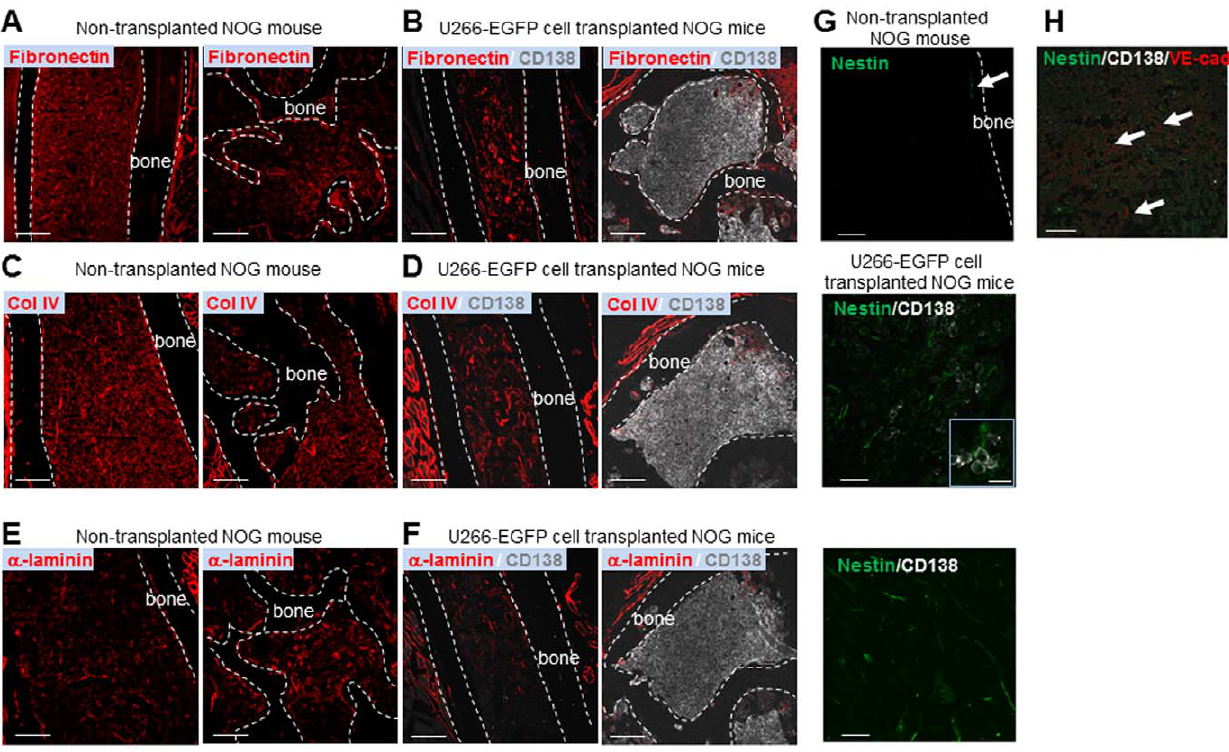
Figure 5. Disorganized ECM components and increased mesenchymal cells in the MM niche. A, B. IHC of fibronectin (red; A ), or fibronectin (red) and human CD138 (gray; B ), at the diaphyseal region (left) or metaphyseal region (right) of long bones of a non-transplanted NOG mouse ( A ) or U266-EGFP cell-transplanted NOG mice ( B ). Representative data from five fields from the BM of one non-transplanted NOG mouse and five U266-EGFP cell-transplanted mice in two independent experiments are shown. Bars=200 m m. C, D. IHC of type IV collagen (red; C ), or type IV collagen (red) plus human CD138 (gray; D ), at the diaphyseal region (left) or metaphyseal region (right) of the long bones of a non-transplanted NOG mouse ( C ) or U266-EGFP cell-transplanted NOG mice ( D ). Representative data from five fields from the BM of one non-transplanted NOG mouse and five U266-EGFP cell-transplanted mice from two independent experiments are shown. Bars=200 m m. E, F. IHC of a -laminin (red; E ), or a -laminin (red) plus human CD138 (gray; F ), at the diaphyseal region (left) or metaphyseal region (right) of the long bones of a non-transplanted NOG mouse ( E ) or U266-EGFP cell-transplanted NOG mice ( F ). Representative data from five fields from the BM of one non-transplanted NOG mouse and five U266- EGFP cell-transplanted mice from two independent experiments are shown. Bars=200 m m. G. IHC of nestin (green; upper panel), or nestin (green) plus human CD138 (gray; middle and lower panels), of the long bones of a non-transplanted NOG mouse (upper panel) or U266-EGFP cell- transplanted NOG mice (middle and lower panels). Nestin + mesenchymal cells were rare in normal NOG BM (upper panel; arrow) but increased in U266-EGFP cell-transplanted mice independent of vascular association (lower two panels). Representative images from five fields from the BM of one non-transplanted NOG mouse and five U266-EGFP cell-transplanted mice from two independent experiments are shown. Bars=40 m m. (Magnified figure bar=20 m m.) H. Triple IHC of nestin (green), CD138 (gray) and VE-cadherin (red) within the metaphyseal regions at 4 weeks after U266-EGFP cell transplantation. Arrows indicate vessels. Representative data from 10 to 20 fields from the BM of two mice from three independent experiments are shown. Bar=40 m m.